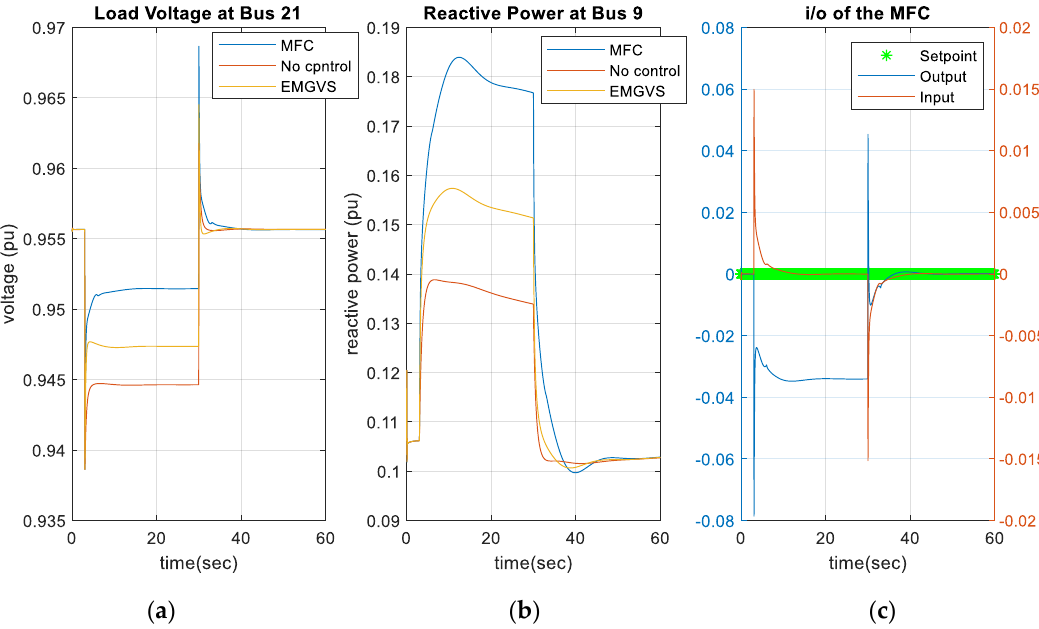
Figure 16. Simulation results for the IEEE 21-bus microgrid system with all PE-based DERs under a 25% load increase at all load buses ( Case 2 )—( a ) load voltage at bus 21; ( b ) reactive power at bus 9; and ( c ) i/o of the MFC .